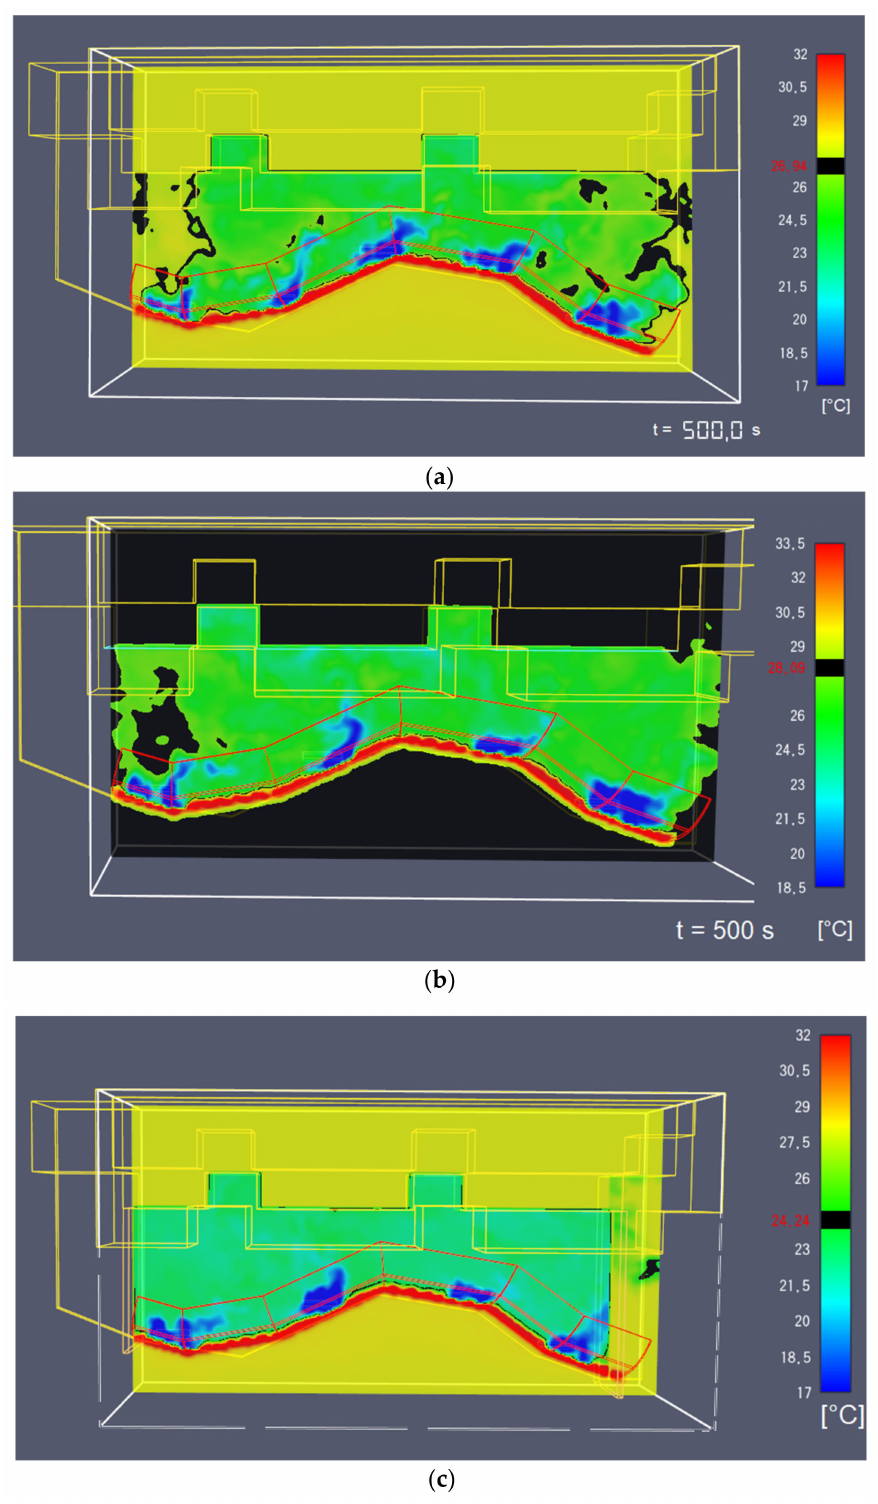
Figure 16. Air temperature distribution in the horizontal section z = 1.1 m, t = 500 s: ( a ) A configura- tion; ( b ) B configuration; and ( c ) C